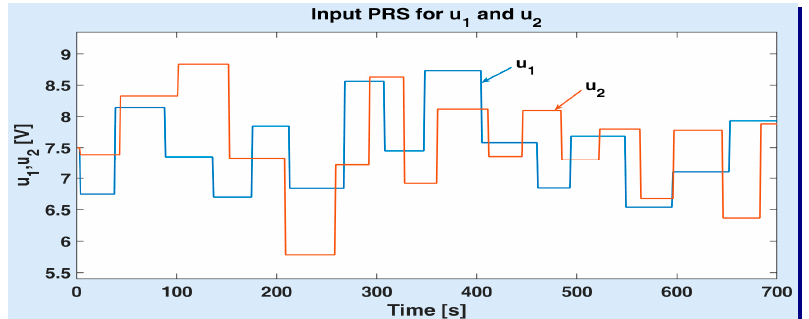
Figure 6. Input signals employed to acquire identification data sets from ASTANK2 installation.